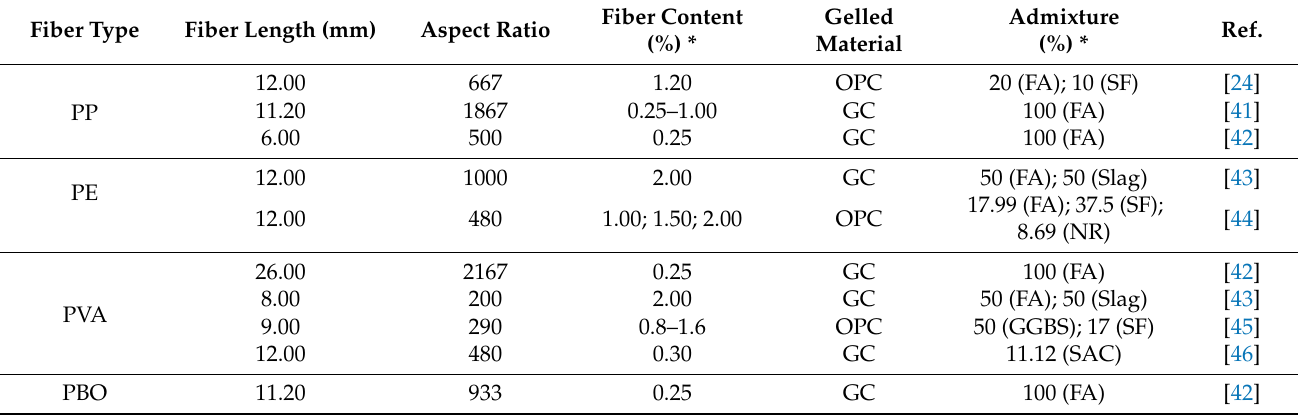
Table 2. Composition of the